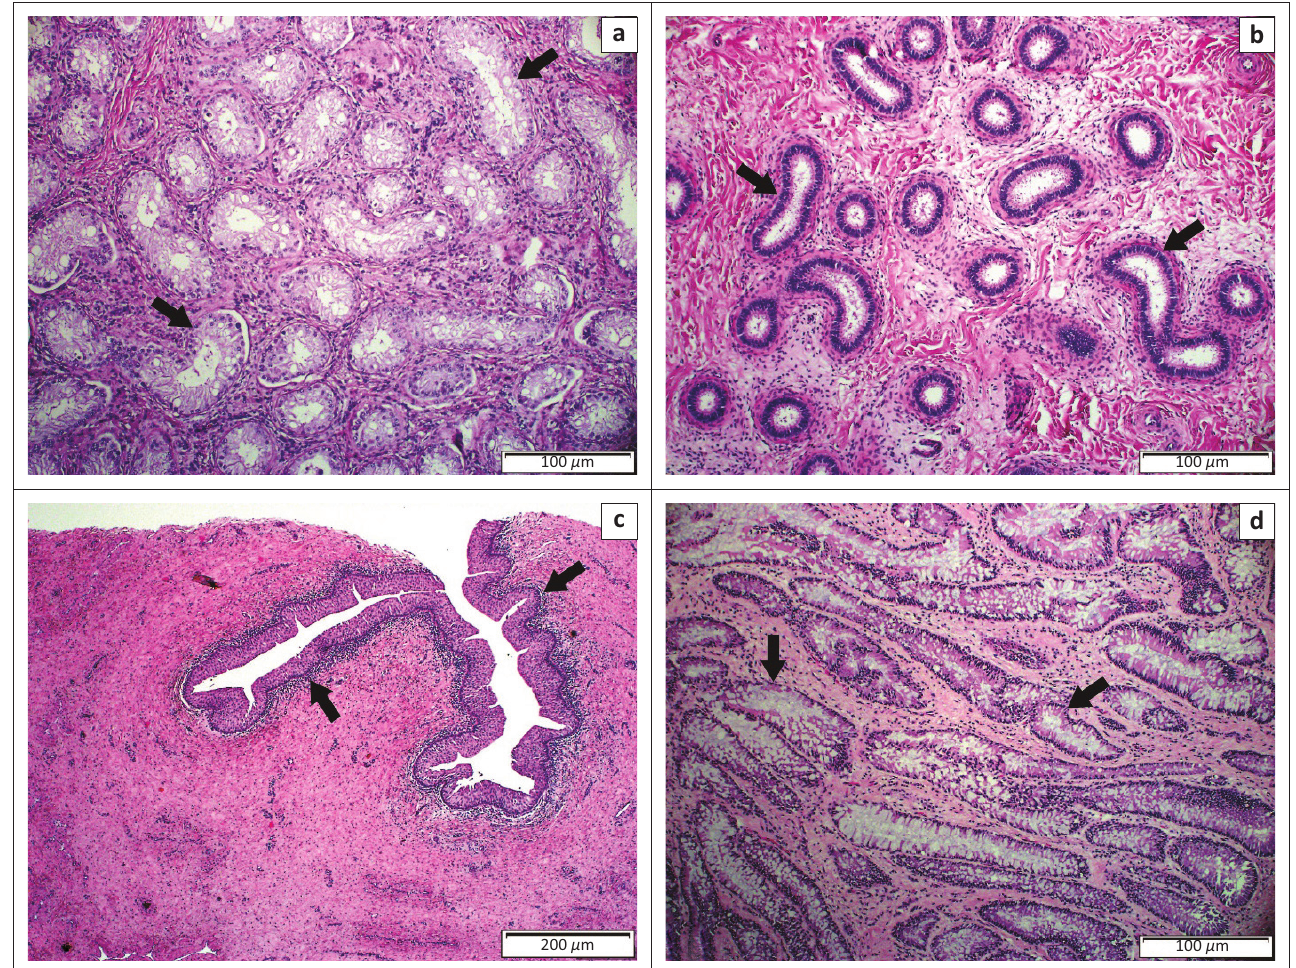
FIGURE 4: Photomicrographs of (a) the testes, (b) epididymis, (c) deferent duct and (d) vesicular gland. (a) Note small immature seminiferous tubules (arrows) lined by Sertoli cells and the absence of seminiferous epithelium. (b) Epididymis coils (arrows) are small, widely separated by fibrovascular connective tissue and contain no spermatozoa. (c) A layer of neutrophils, lymphocytes and plasma cells (arrows) occurs in the superficial submucosa of the deferent duct. (d) Note the branching tubular glands (arrows) of the deep portion of the vesicular